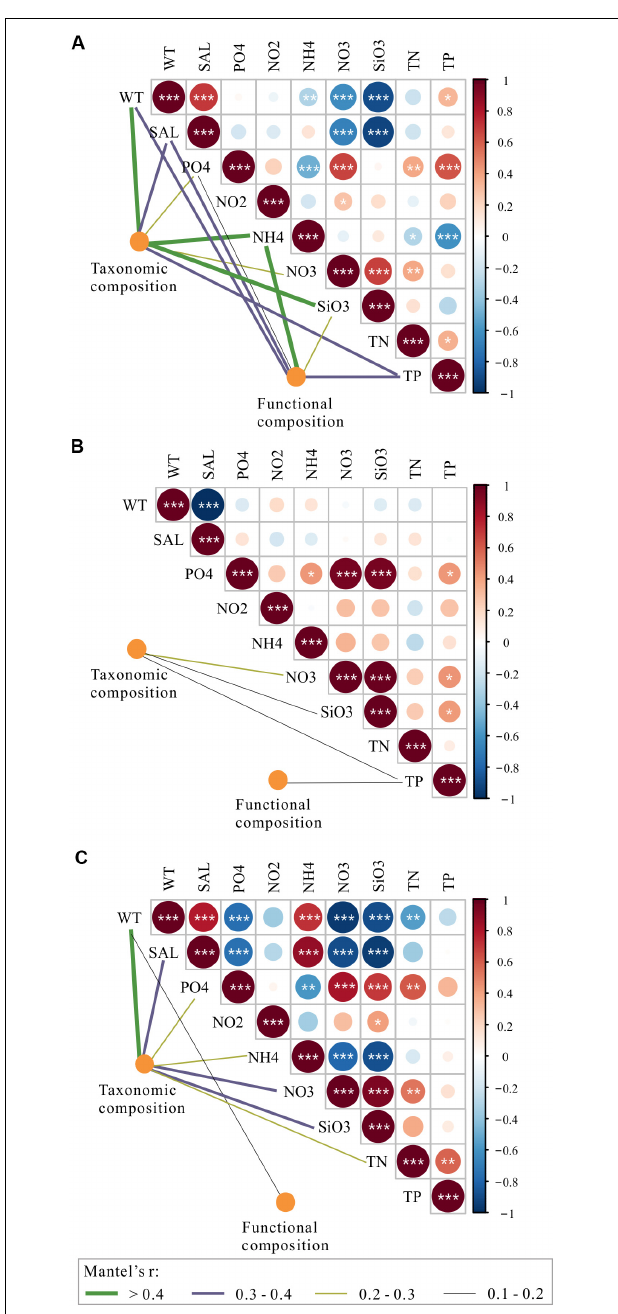
FIGURE 9 | Environmental drivers of taxonomic and functional composition of total bacterioplankton communities (A) and the bacterioplankton communities collected in November (B) and April (C) . Pairwise comparisons of environmental variables are shown with a color gradient denoting Spearman’s correlation coefficients. The taxonomic and functional composition of bacterioplankton communities was related to each environment variable by partial (geographic distance-corrected) Mantel tests. Edge width corresponds to Mantel’s r statistic for the corresponding distance correlations, and edge color denotes the statistical significance based on 9999 permutations. WT, water temperature; SAL, salinity; PO 4 , orthophosphate; NO 2 , nitrite; NO 3 , nitrate; NH 4 , ammonium; SiO 3 , silicate; TN, total nitrogen; TP, total